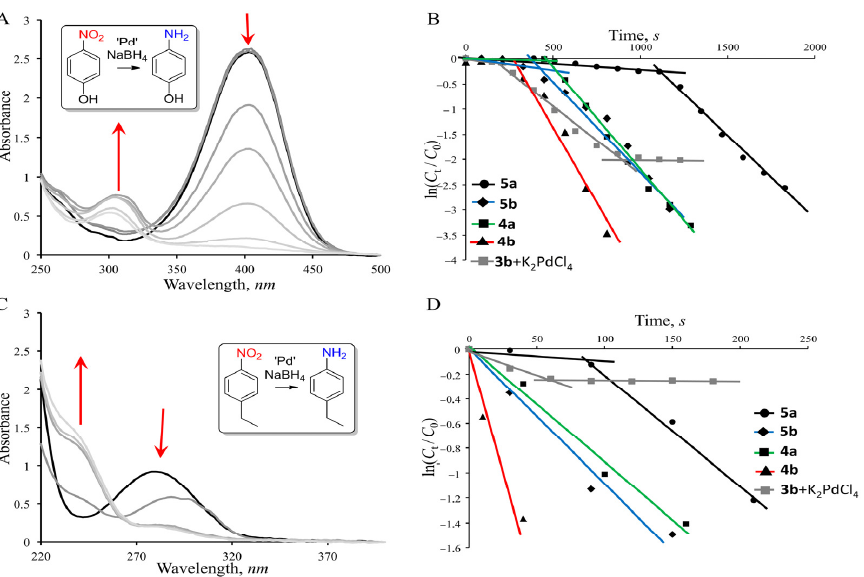
Figure 2. Changes in the UV–VIS spectrum during the reduction of ( A ) p -nitrophenol and ( C ) p -ethylnitrobenzene in the presence of 4b ; dependence of ln(C t /C 0 ) vs. t in the presence of different Pd sources: ( B ) for p -nitrophenol and ( D ) p -ethylnitrobenzene. C ( p -nitrophenol) = C ( p -ethylnitrobenzene) = 0.1 mM, C (NaBH 4 ) = 5 mM, C ( 5a , b ; 4a , b , 3b and K 2 PdCl 4 ) = 0.02 mM, H 2 O:THF=3:1, 20 ◦ C, and V = 1.2 mL.